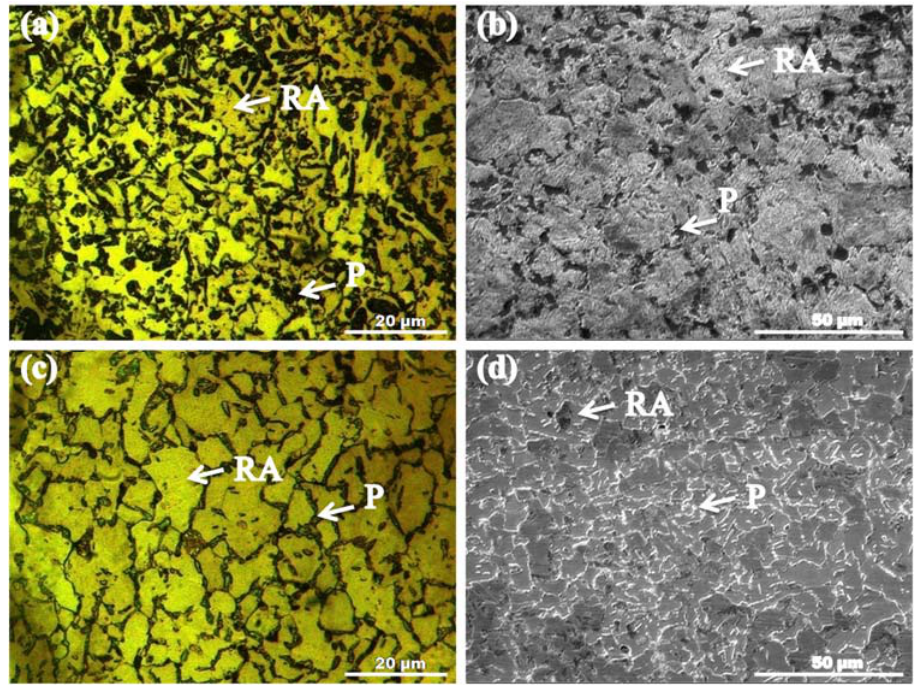
Figure 3. Microstructure of TMDA treated; ( a ) optical micrograph, ( b ) SEM micrograph, and TMTA treated; ( c ) optical micrograph, and ( d ) SEM micrograph experimental AISI 1345 steel containing pearlite (P) and retained austenite (RA) phases.